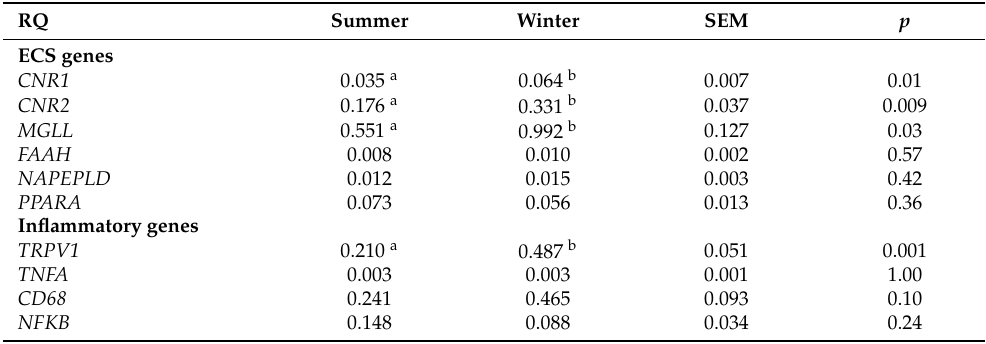
Table 2. Relative mRNA expression in adipose tissue (AT) at 7 d PP in cows calving during summer or